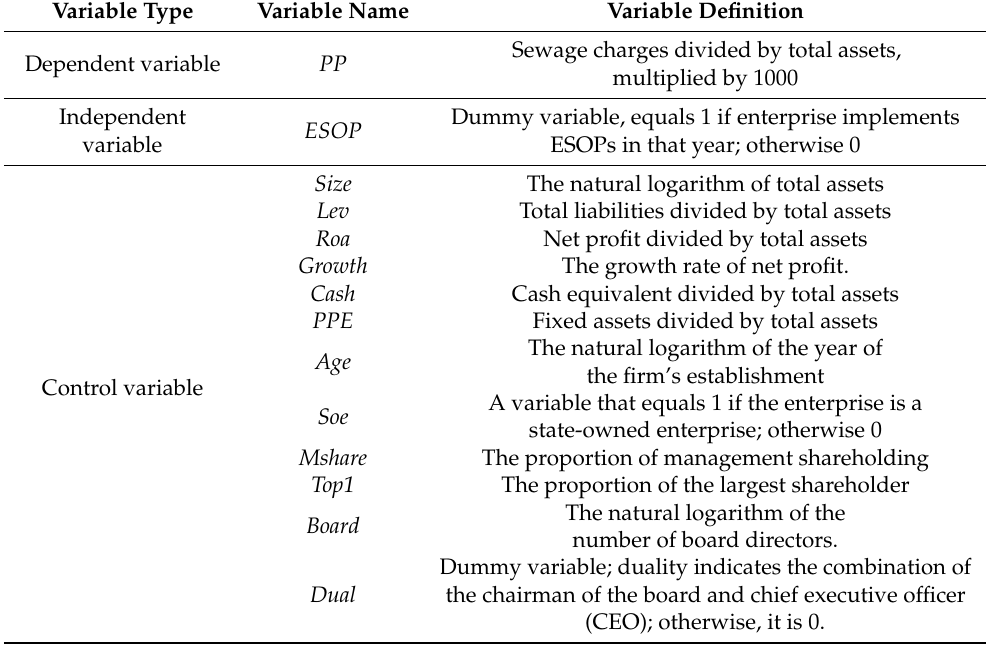
Table 1. Variable